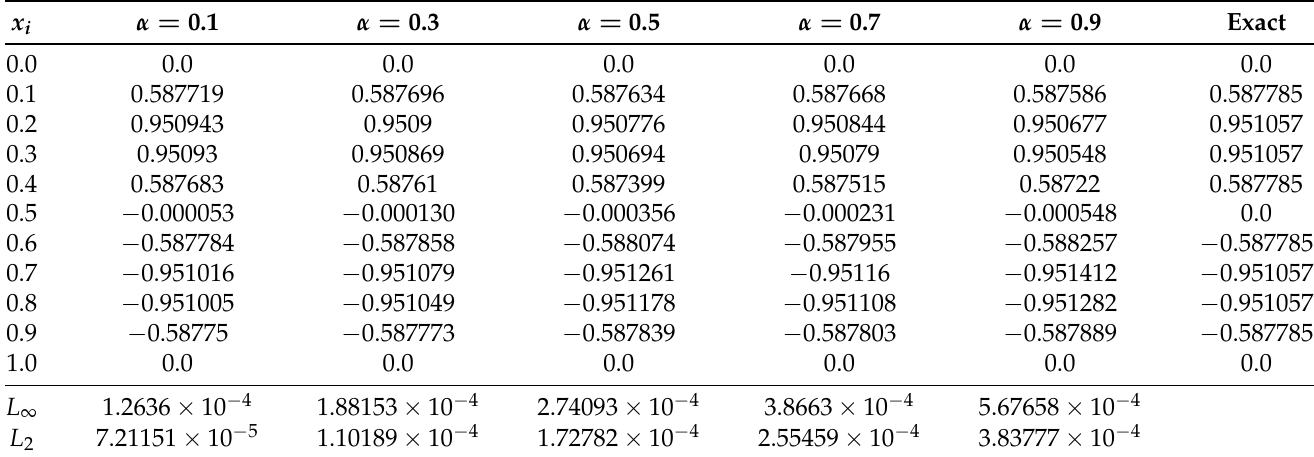
Table 2. Error norms, numerical solutions and comparison of the exact solution of real part of